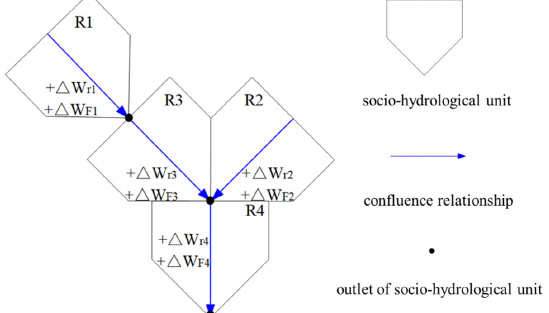
Figure 2. Mutual feedback mechanism of upstream and downstream socio-hydrological units; the blue line represents the confluence relationship. Within each calculation unit, ∆𝑊 (cid:3045) is the runoff in the unit caused by natural runoff and confluence; ∆𝑊 (cid:3007) is the feedback amount of the social water cycle, which is the change of runoff in the unit caused by social water intake and drainage. The water volume at the outlet of the unit is 𝑊 (cid:3045) when only the natural water cycle is considered, and the water volume at the outlet of the unit is 𝑊 (cid:3007) when the mutual feedback mechanism of the natu ‐ ral society dualistic water cycles is considered. For example, for a unit, if the amount of the runoff produced within the unit is 10 million m 3 , then ∆𝑊 (cid:3045) is 10 million m 3 ; if the water intake is 4 million m 3 , and water drainage is 2 million m 3 , then the change in runoff in the unit caused by social water intake and drainage is – 2 million m 3 ; thus ∆𝑊 (cid:3007) is – 2 million m 3 ; the 𝑊 (cid:3045) is 10 million m 3 , and the 𝑊 (cid:3007) is 8 million m 3 . Thus, the water balance of each unit can be determined from: (cid:3422) 𝑊 (cid:3045)(cid:2869) (cid:3404) ∆𝑊 (cid:3045)(cid:2869) 𝑊 (cid:3045)(cid:2870) (cid:3404) ∆𝑊 (cid:3045)(cid:2870) 𝑊 (cid:3045)(cid:2871) (cid:3404) 𝑊 (cid:3045)(cid:2869) (cid:3397) ∆𝑊 (cid:3045)(cid:2871) 𝑊 (cid:3045)(cid:2872) (cid:3404) 𝑊 (cid:3045)(cid:2870) (cid:3397) 𝑊 (cid:3045)(cid:2871) (cid:3397) ∆𝑊 (cid:3045)(cid:2872)